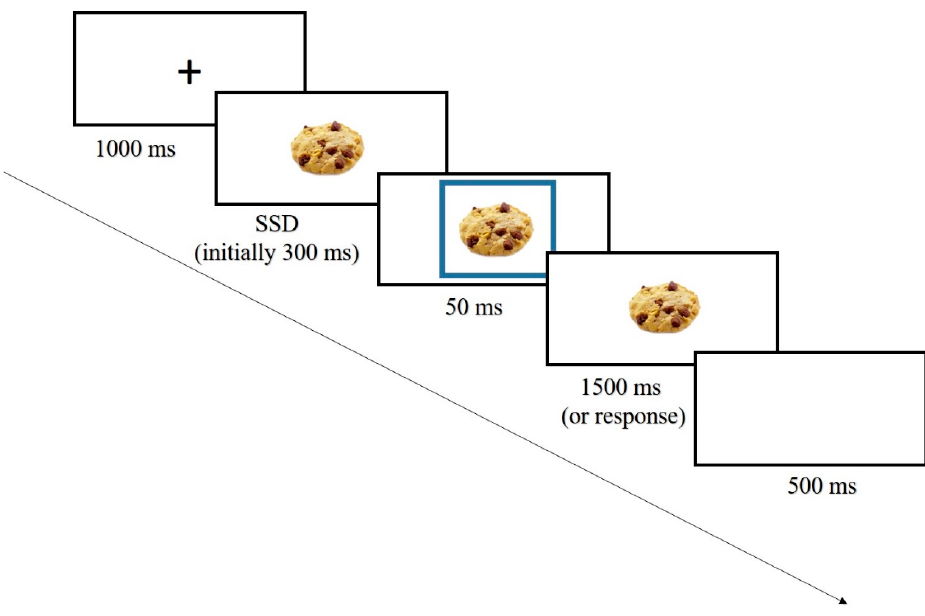
Figure 1. An example of a stop-food trial in the F-SST (food stop-signal task).